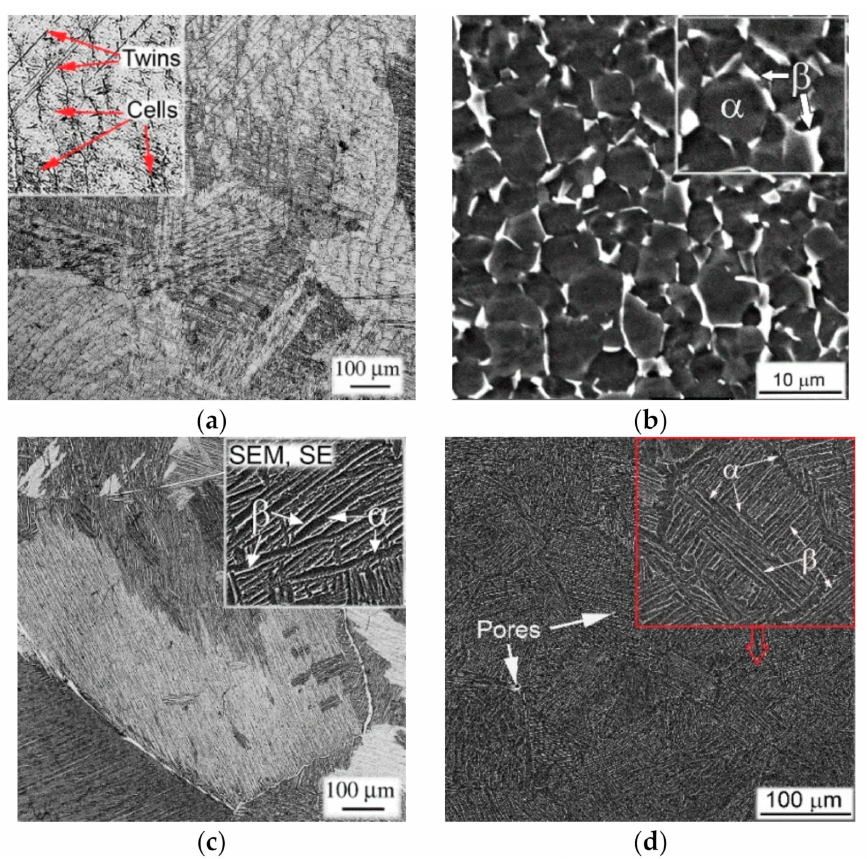
Figure 3. Microstructure of Ti-based materials in the initial state: ( a ) c.p.Ti; ( b ) Ti64GL; ( c ) Ti64LM;